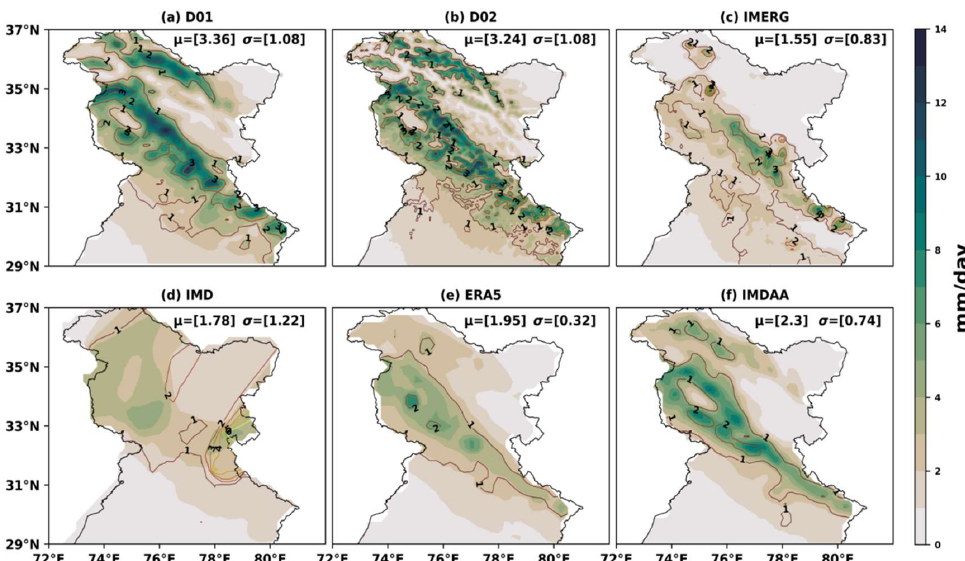
Figure 3. Seasonal (DJF) average precipitation captured by WRF model; D01 ( a ), D02 ( b ) and precipitation products; IMERG ( c ), IMD ( d ), ERA5 ( e ) and IMDAA ( f ). Shading and contours represent the magnitude of seasonal average precipitation and standard deviation, respectively.